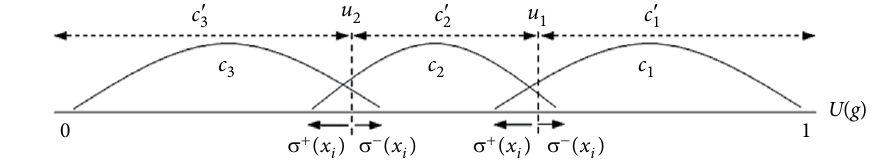
Fig. 2. Representation of misclassification errors for a predefined three classification group